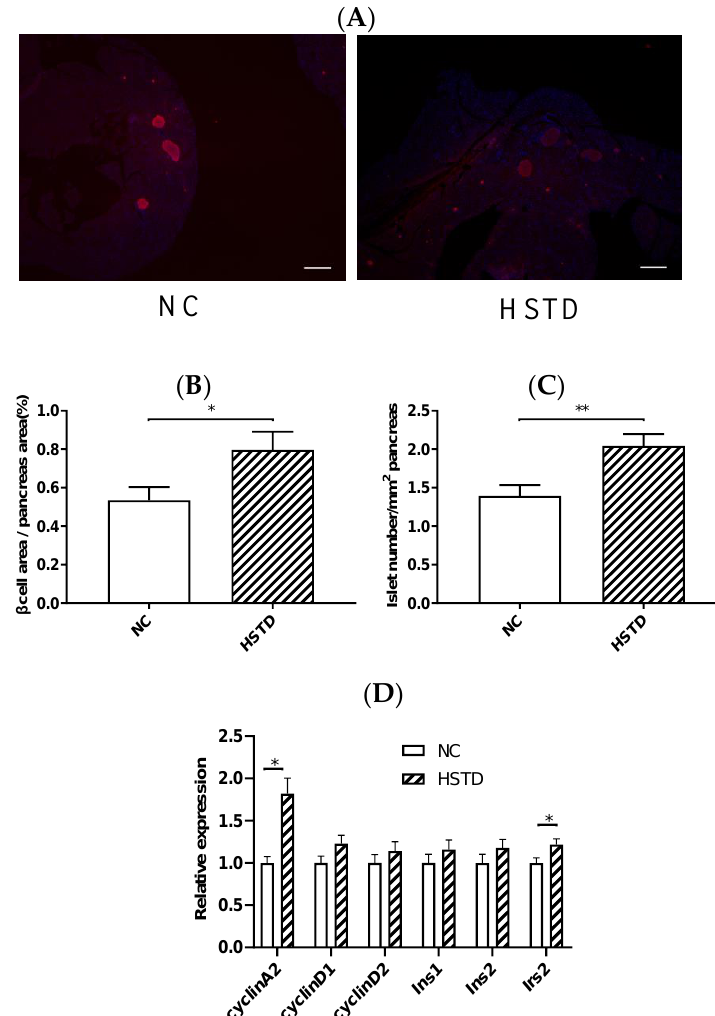
Figure 3. BCM, islet number and mRNA expression levels of islets 5 weeks after intervention of diet in mice. ( A ) The pancreatic section was stained with the antibody to insulin (red) and 40,6-diamidino-2-phenylindole (blue). Scale bars, 300 μm. ( B ) β-Cell area relative to pancreas area. ( C ) Number of islets relative to pancreas area. ( D ) mRNA expression levels of the indicated genes in isolated islets of mice fed NC (white bar; n = 16) or HSTD (white hatched bar; n = 18) 5 weeks after intervention of diet. Statistical comparisons were done by unpaired Student’s t test in ( B , C ) and multiple t tests in ( D ). Correction for multiple comparisons was performed by using the Holm-Šidák method. Data represent means ± SEM. * p < 0.05, ** p < 0.01.